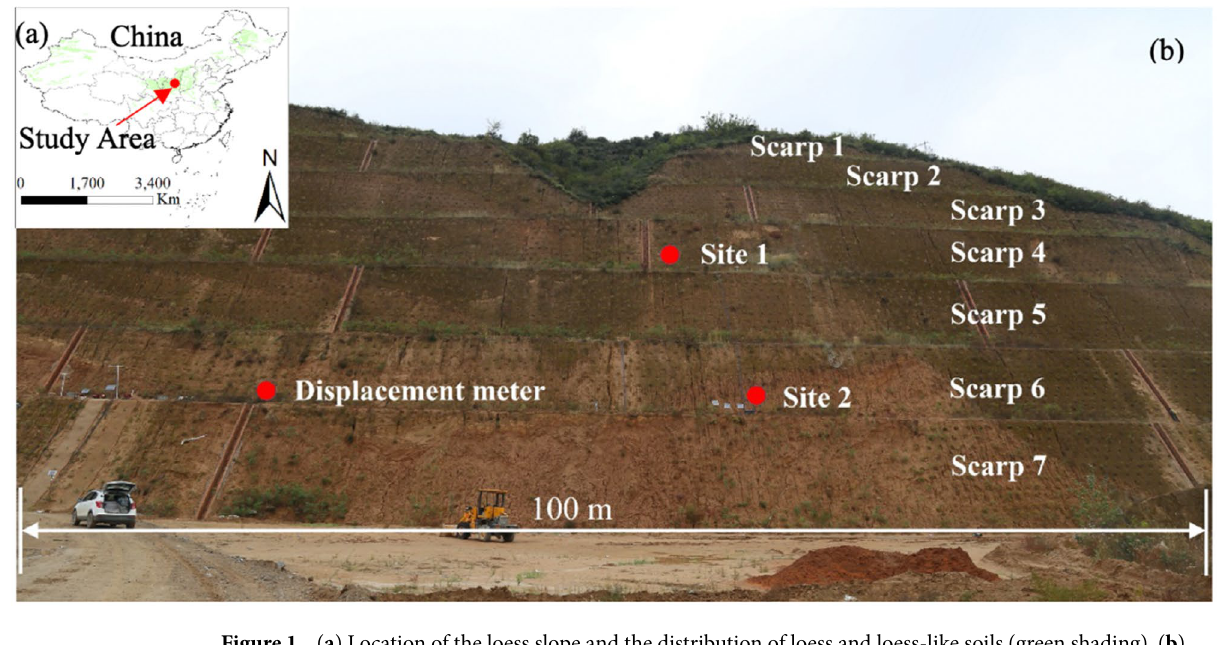
Figure 1. ( a ) Location of the loess slope and the distribution of loess and loess-like soils (green shading). ( b ) View of the loess slope near Yan’an. The red dots indicate the locations of instruments.